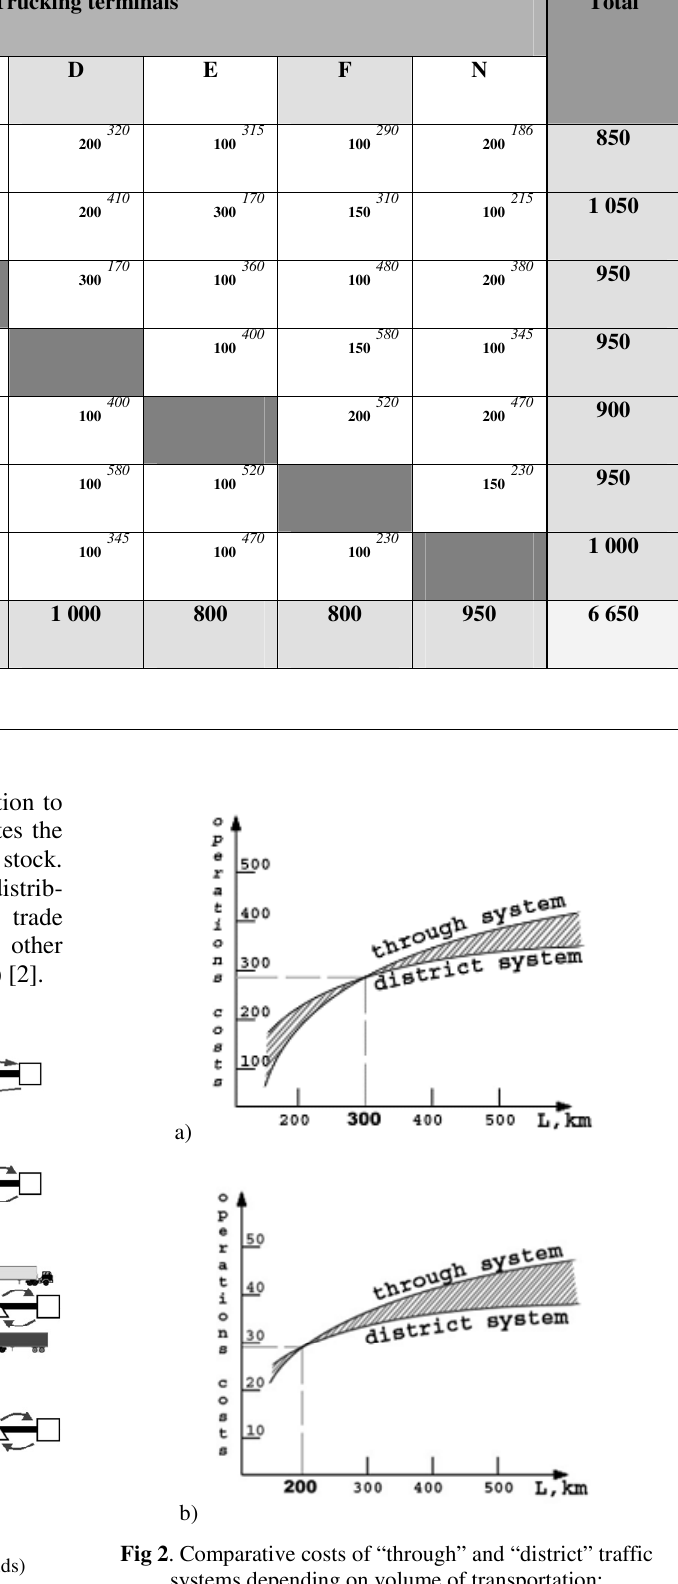
Trucking terminals Arrival